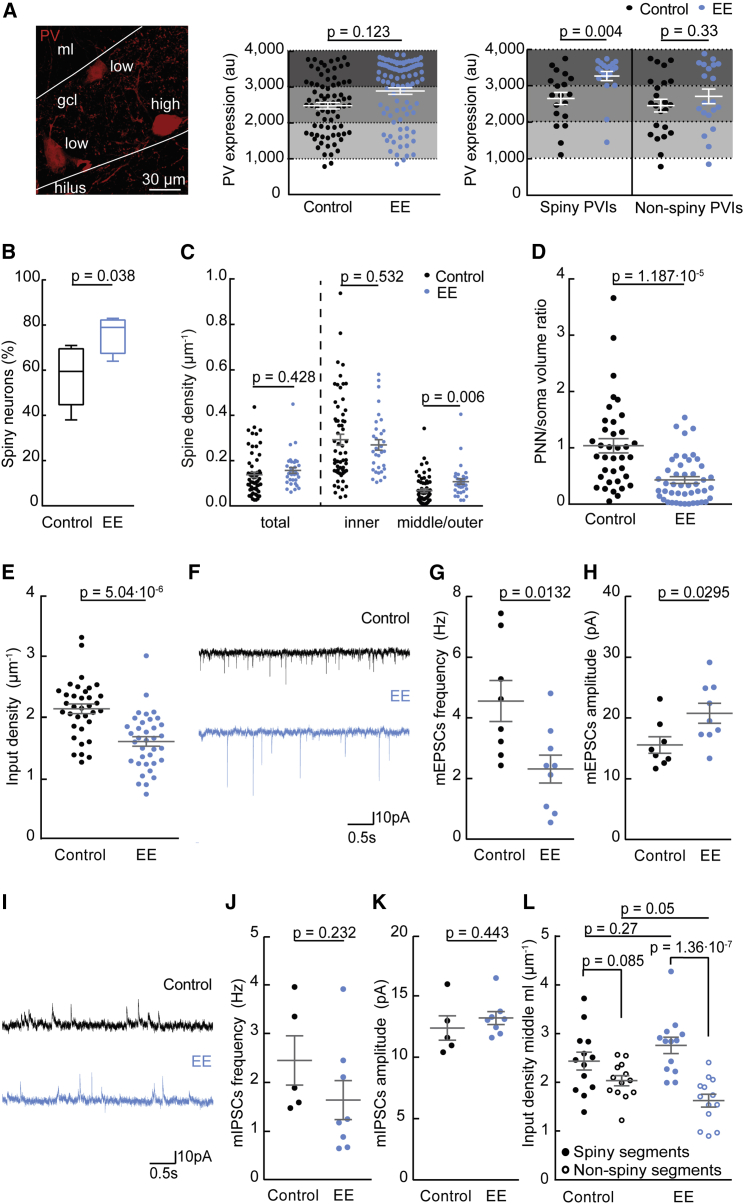
Experience-Induced Plasticity of Spiny PVIs(A) Left, confocal image showing PVIs with different expression levels of PV protein as detected by immunofluorescence (red). Middle, when analyzed for the entire PVI population, PV expression levels were only slightly higher in EE than in control mice (each data point represents PV expression in one cell; n = 168 cells, 3 control and 4 EE mice). Right, however, when analyzed separately these changes in PV expression were significant in spiny but not in non-spiny PVIs (n = 82 cells in 3 control and 4 EE mice).(B) EE exposure increased the proportion of spiny PVIs (n = 144 neurons, 6 control and 4 EE mice).(C) Total spine densities of individual cells as well as spine densities in the inner ml were unchanged after EE, but spine densities in the middle and outer ml were increased (n = 92 cells, 6 control and 4 EE mice).(D) PNN wrapping of PVI somata was strongly reduced after EE compared to control conditions (n = 83 cells in 3 control and 4 EE mice).(E) Total input density (identified as appositions of PSD95- and VGLUT1-positive puncta) of PVIs declined after EE exposure (n = 71 cells in 3 control and 4 EE mice).(F–H) Example traces (F), frequency (G), and amplitude (H) of mEPSCs (n = 8 and 9 cells in 3 control and 4 EE mice) in PVIs of control and EE mice.(I–K) Example traces (I), frequency (J), and amplitude (K) of mIPSCs (n = 5 and 8 cells in 3 control and 4 EE mice) in PVIs of control and EE mice. Note the decrease in frequency but increase in amplitude of mEPSCs.(L) Whereas spiny and non-spiny segments displayed similar input densities (appositions of PSD95- and VGLUT1-positive puncta) in control mice, EE mice showed reduced input densities on non-spiny segments (n = 52 segments in 3 control and 4 EE mice). Bars are means ± SEM.